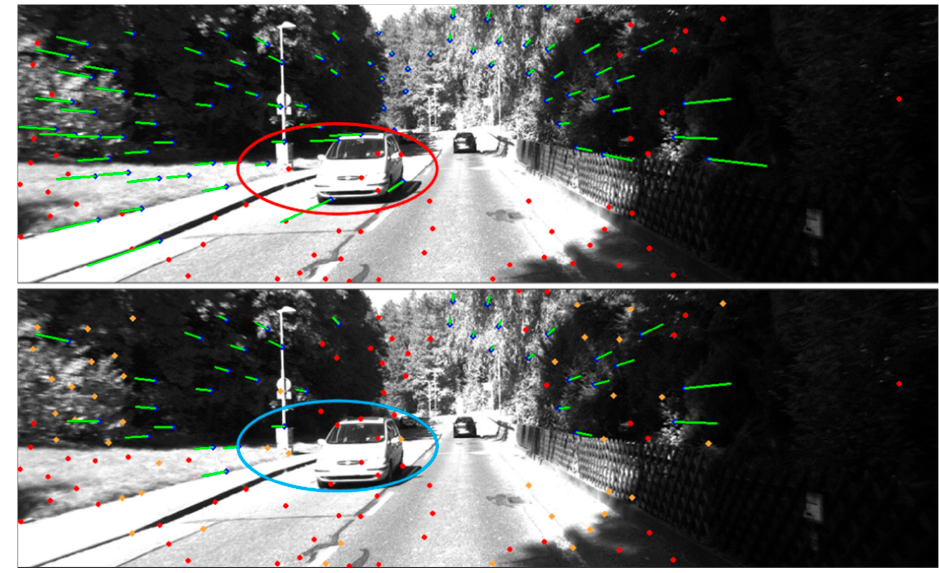
Figure 12. Top: before optimization (top image). Bottom: after optimization (sequence 09; frame 1436). Figure 13 and Table 3 show the results with or without photogrammetric feature optimization.